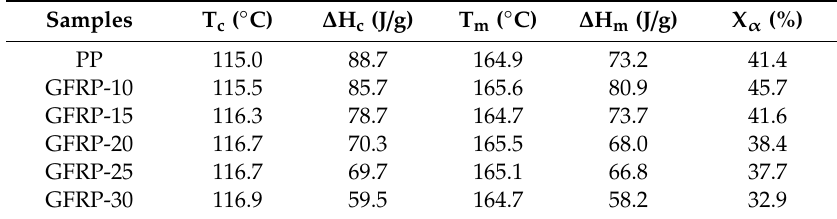
Table 1. Crystallization and melting characteristics of GFRP with di ff erent ratio of glass fiber (GF). PP: Polypropylene.